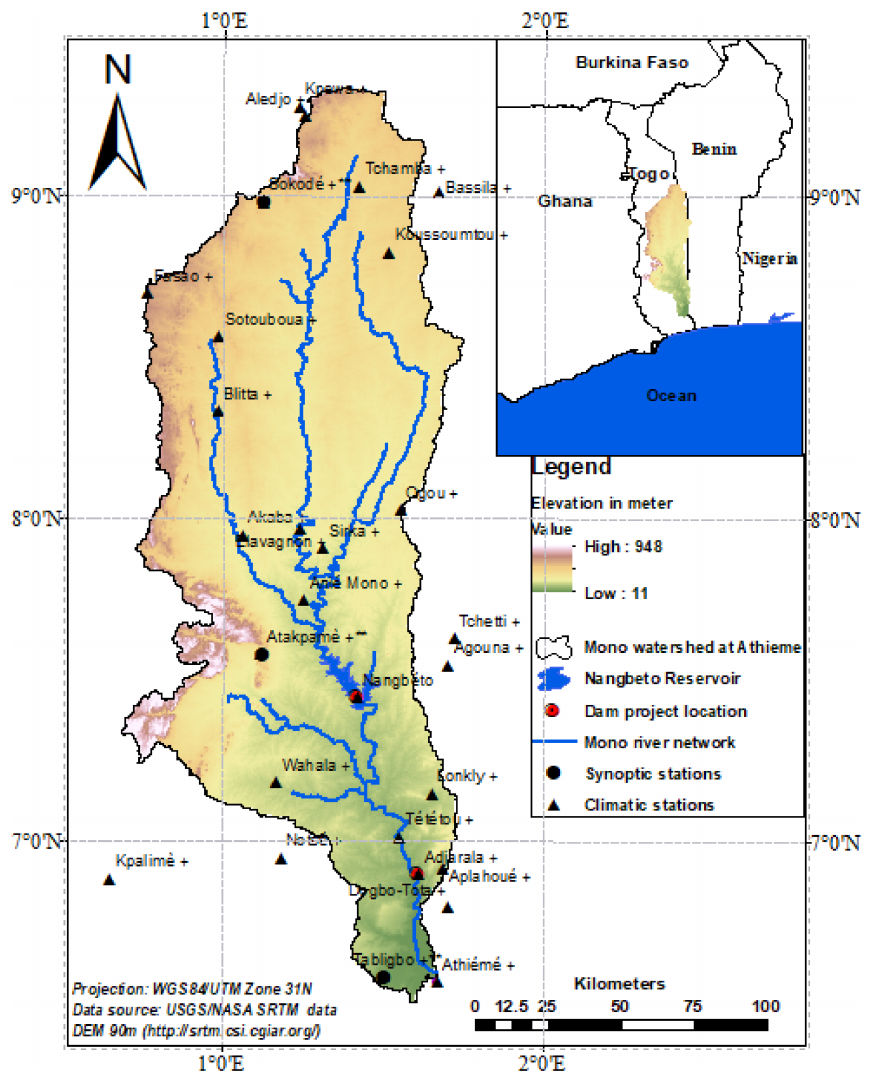
Figure 1. Location of the Mono